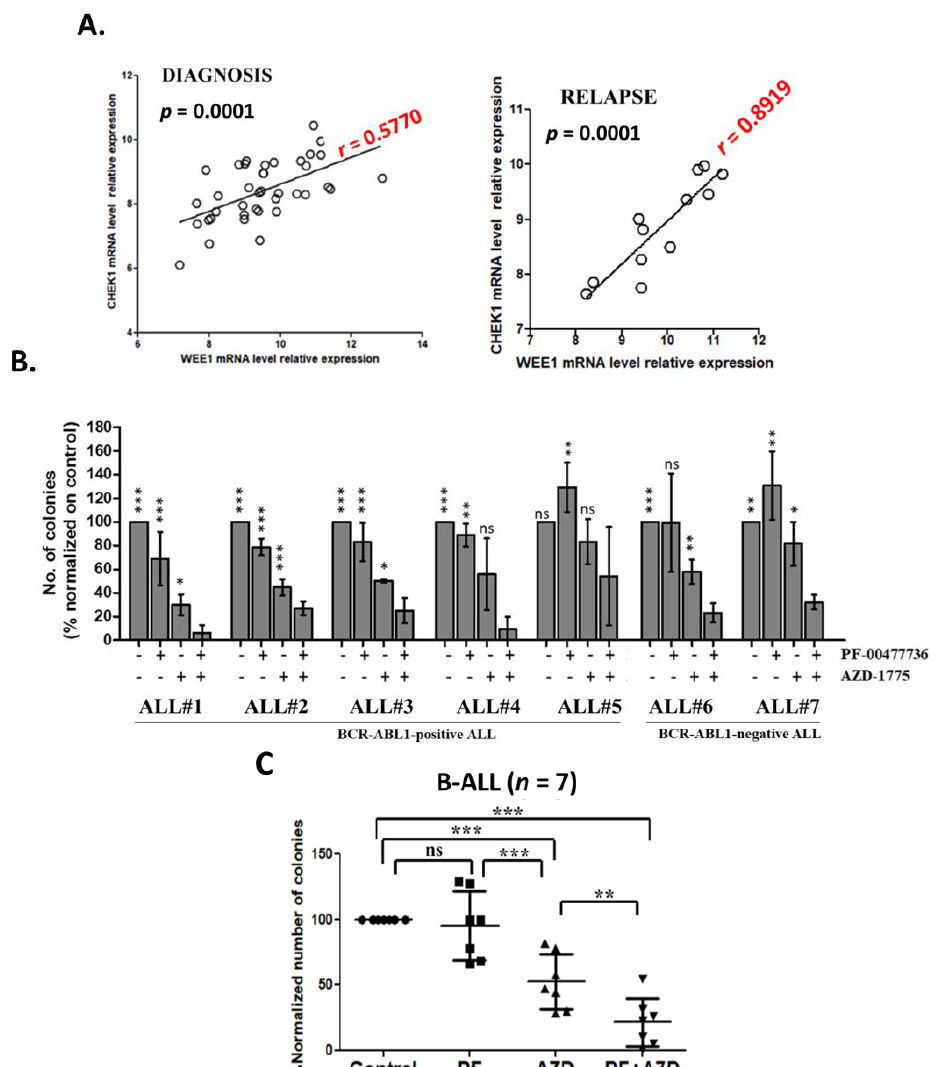
Figure 4. The inhibition of CHK1, CHK2 e WEE1 compromises primary leukemic B-ALL clonogenic capacity. ( A ) Dot plot showing the Pearson correlation ( r value) of Wee1 and Chek1 relative mRNA level in primary leukemic ALL samples at diagnosis ( n = 39) and at relapse ( n = 14). On the top of each dot plot is reported the statistical significance of the analysis and on the linear regression is reported in